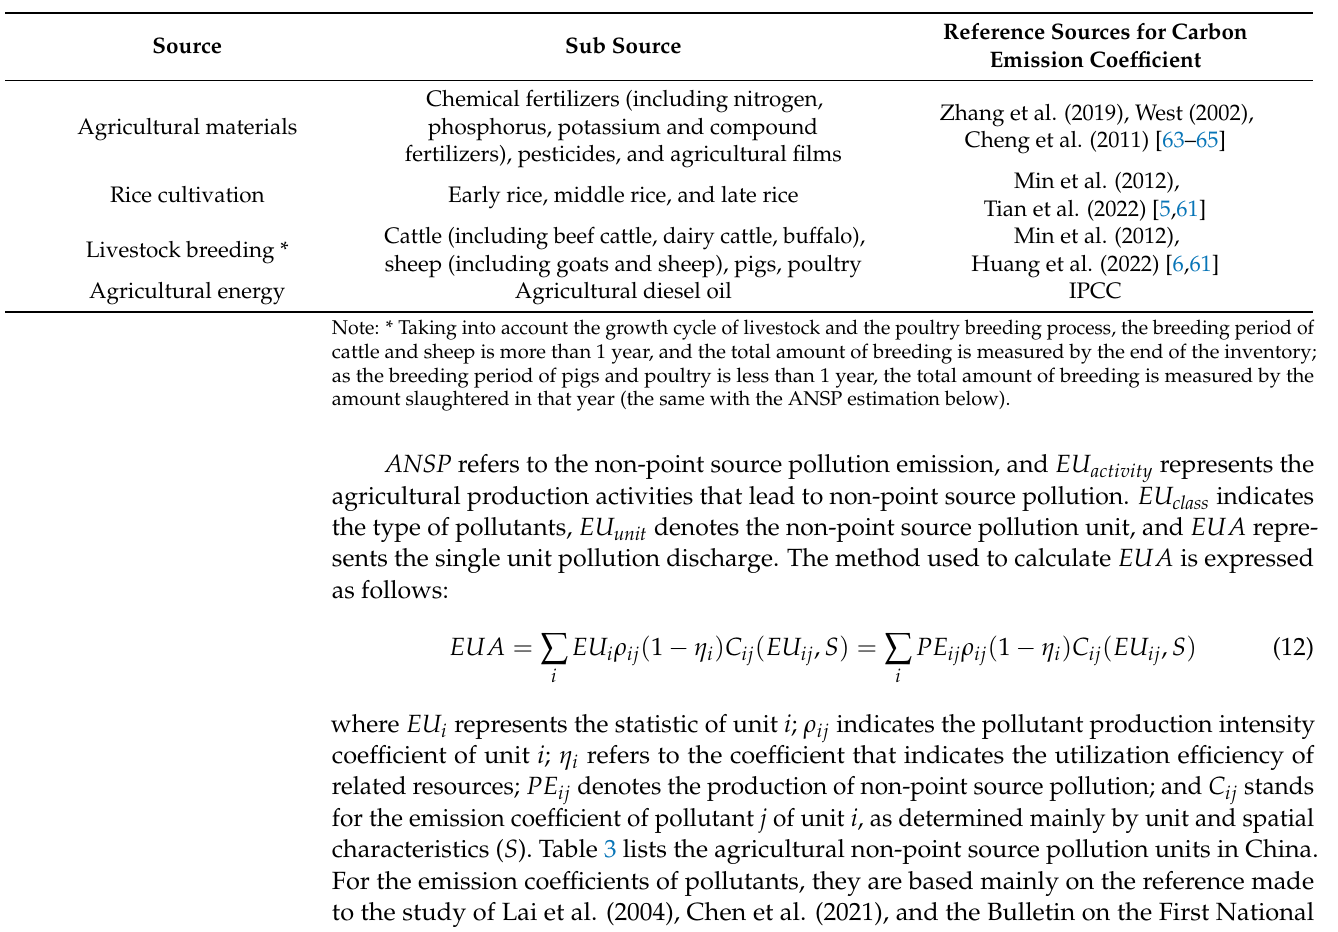
Table 2. Agricultural carbon emission.